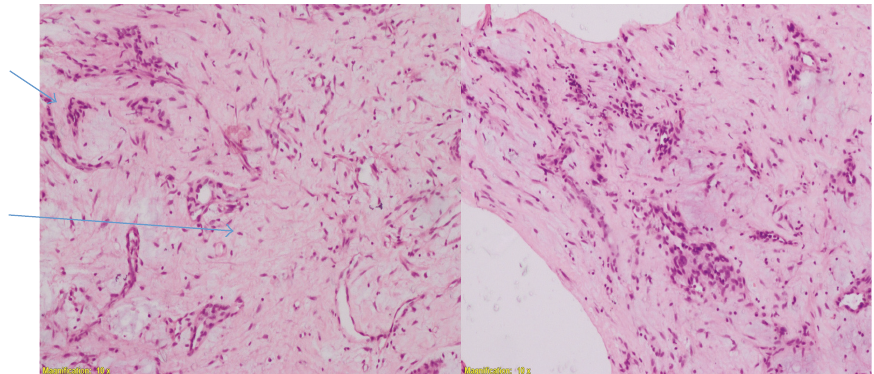
Figure 4: H&E stain with × 10 magnification, showing proliferation of bland myofibroblastic cells and arborizing capillaries in a loose myxoid stroma and plexiform pattern